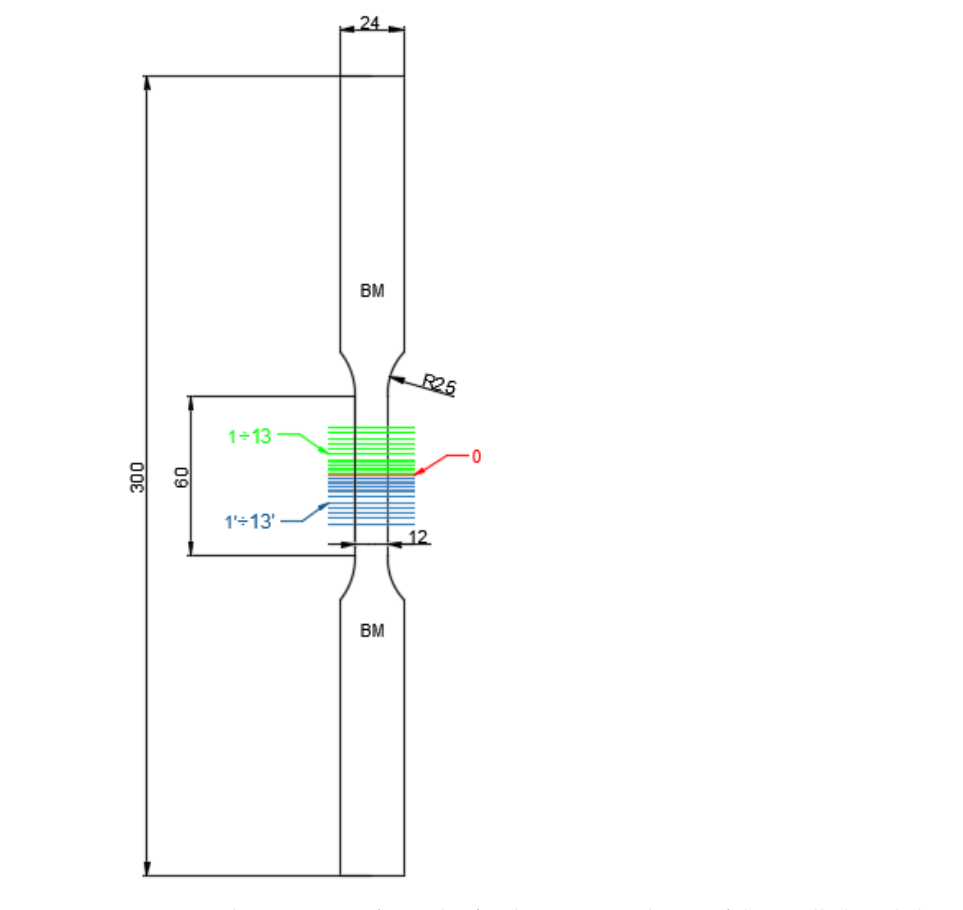
Figure 1. The geometry of samples for the static tensile test of thin-walled steel elements bonded by various methods. Designation of areas used for analysis using the digital image correlation system (DIC): 0—a center of the welded joint, BM—based material, 1 ÷ 13—an area of the analyzed sample from the weld axis upwards, and 1' ÷ 13'—an area of the analyzed sample from the axis weld down. (Unit: mm)